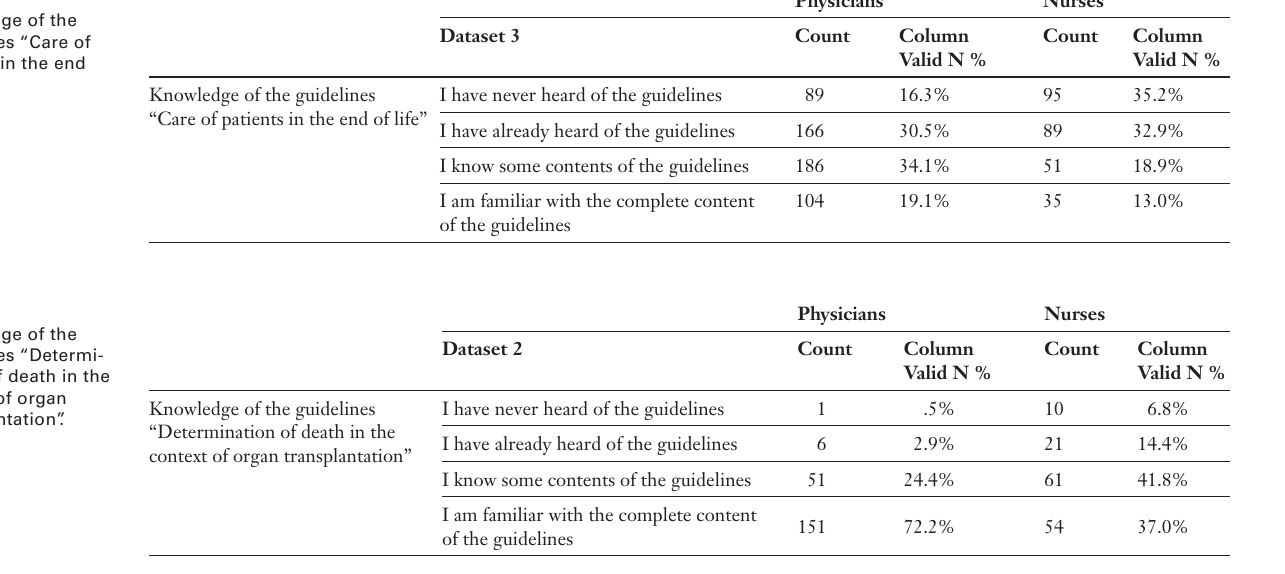
Knowledge of the guidelines “Care of patients in the end of life”.